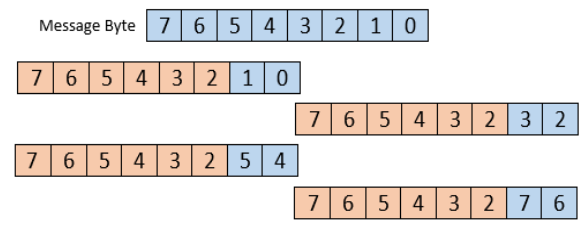
Figure 1. Embedding with message bytes .